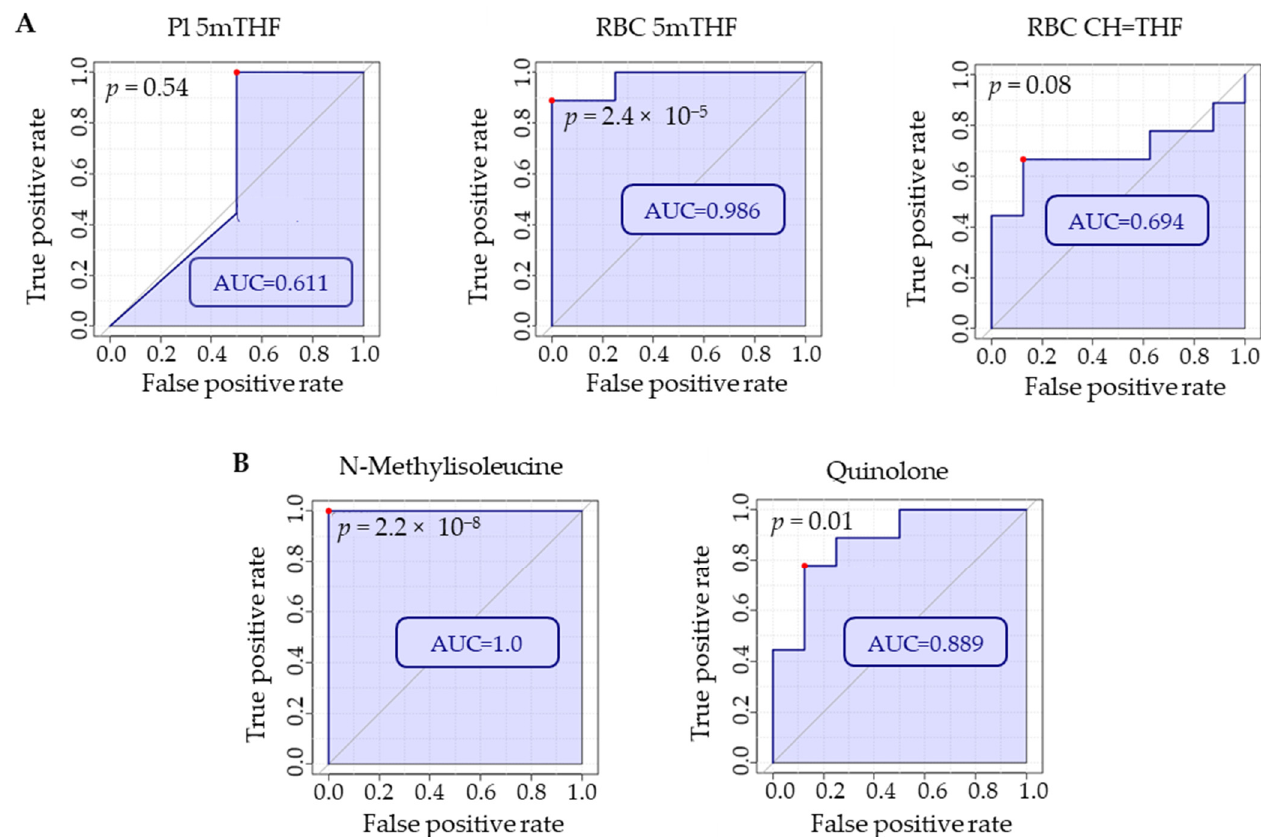
Figure 7. Using MetaboAnalyst 5.0, ROC curve analyses were conducted on ( A ) folate levels in plasma and RBCs and ( B ) plasma metabolites identified by semitargeted global metabolomic profiling (i.e., NMI and quinolone) to compare which markers were most discriminatory with regard to MTX treatment. Red dots on each plot indicate the optimal cut-off based on specificity and sensitivity. Comparison is based on metabolite levels in RBC or plasma for disease mice ( n = 8) and disease mice treated with MTX ( n = 9).